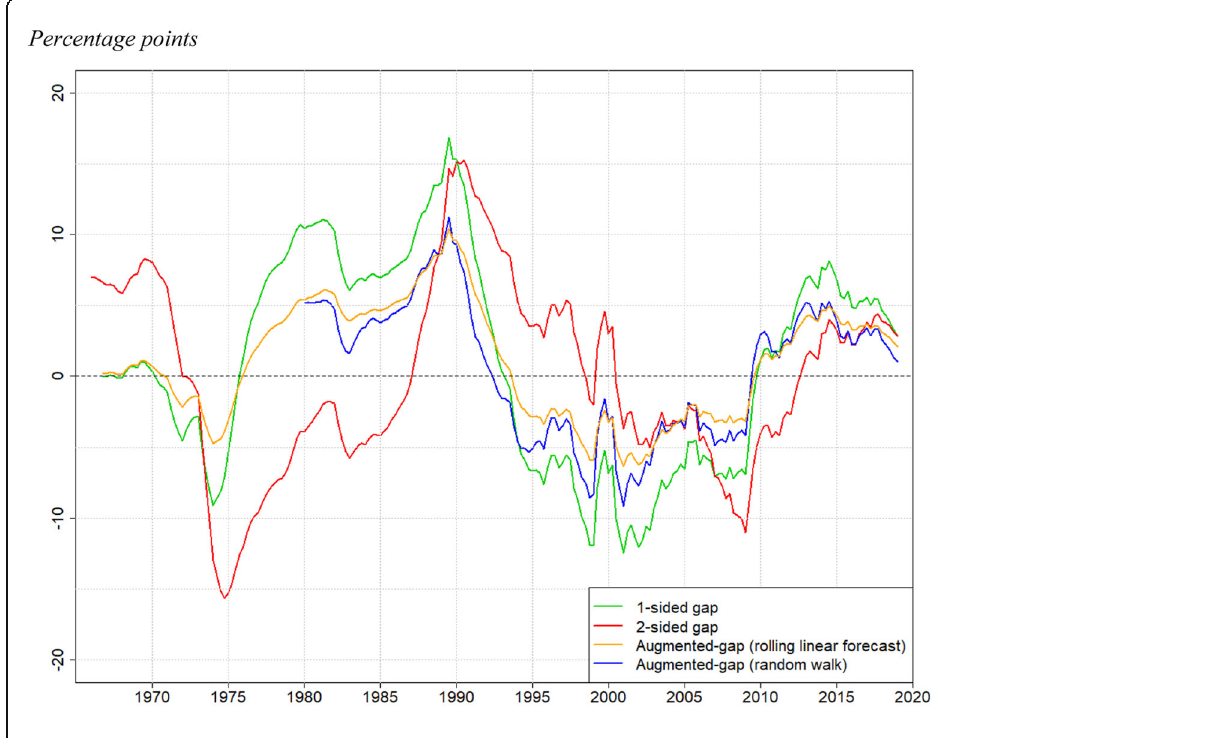
Fig. 10 Credit-to-GDP gap, impact of augmenting historical observations with forecasted data. Percentage